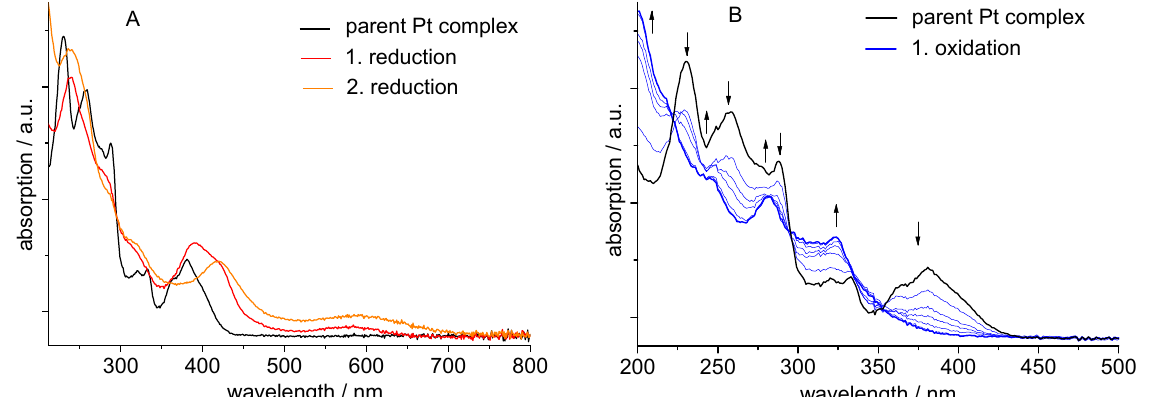
Figure 5. UV-vis absorption spectra of [Pt(Me 2 dpb)Cl] in THF/ n -Bu 4 NPF 6 , recorded during cathodic reduction ( A ) and anodic oxidation ( B ).